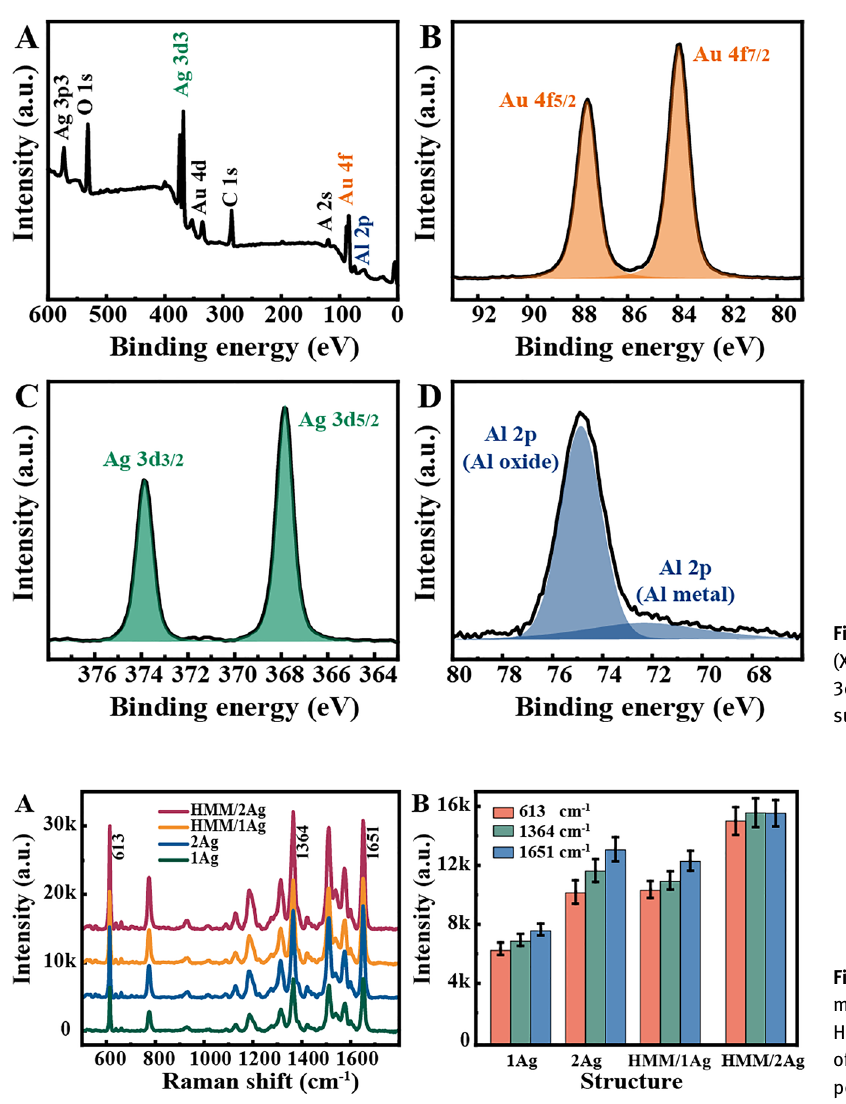
Figure 6: (A) Raman spectra of R6G molecules (10 − 6 M) detected from 1Ag, 2Ag, HMM/1Ag, and HMM/2Ag. (B) The intensity of the R6G at 613, 1364, and 1651 cm − 1 peaks detected in various